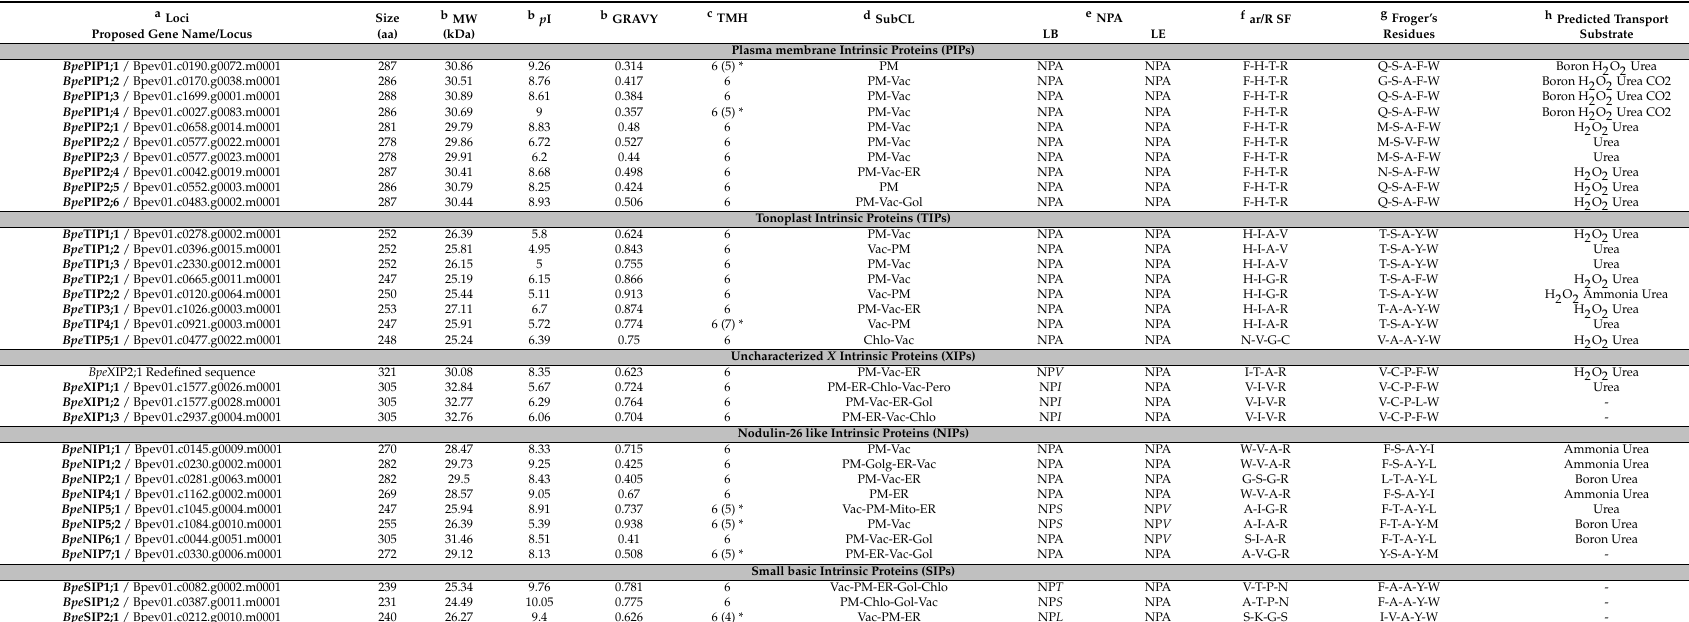
Table 1. Nomenclature and protein properties of the Bpe AQPs from Betula pendula (complete sequences). a Loci